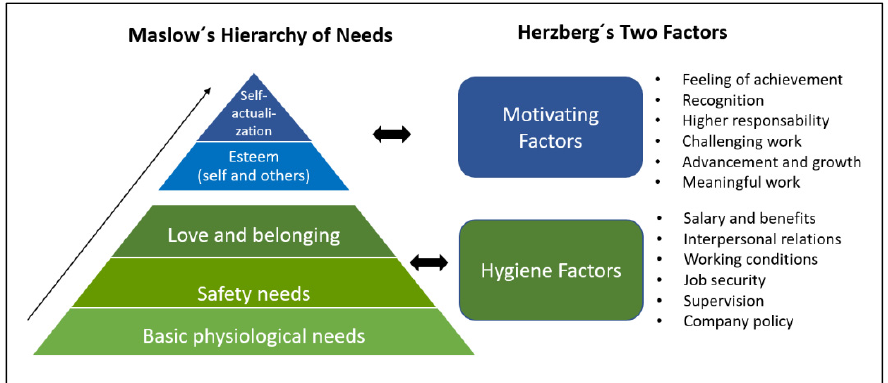
Figure 2. Comparison of Maslow’s and Herzberg’s theories of motivation. Source: Own elaboration. Adapted from Maslow´s and Herzberg´s theories .